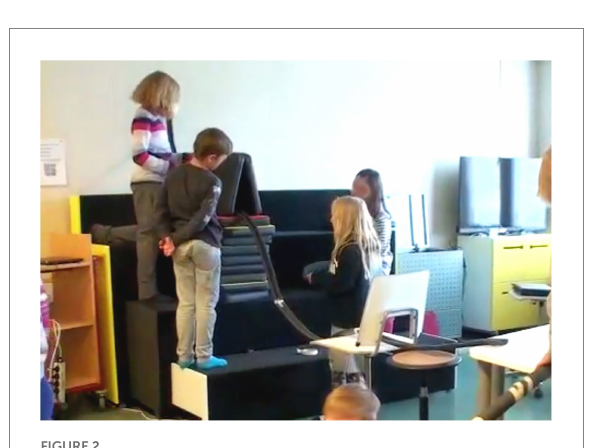
FIGURE 2 The innovative roller coaster constructed by four students in the FUSE Studio